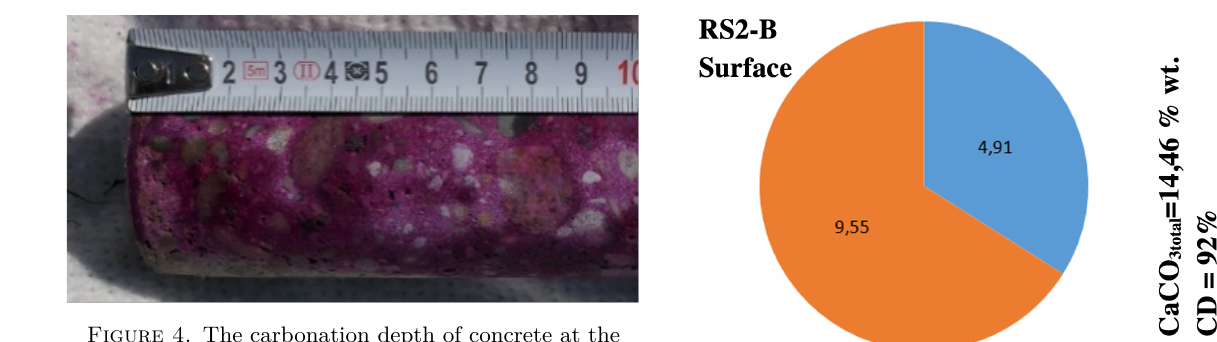
Figure 4. The carbonation depth of concrete at the places with a thin layer of PRC at the surface - sample selected from the measurements performed in 2018 (Bridge in Sládkovi č ovo).